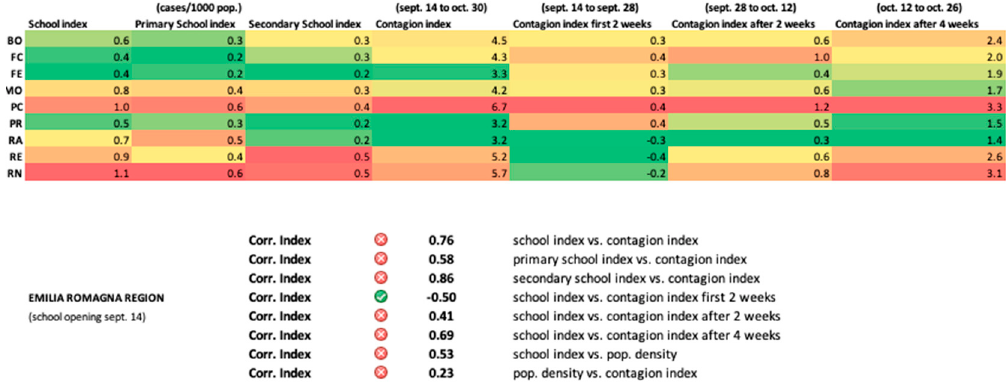
Figure 5. Emilia Romagna Region data set for school contagion index and overall contagion. Correlation study.